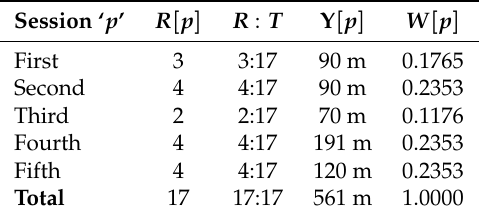
Table 2. The weight of each edge, which equals the ratio of the number of task cycles to the total daily number of